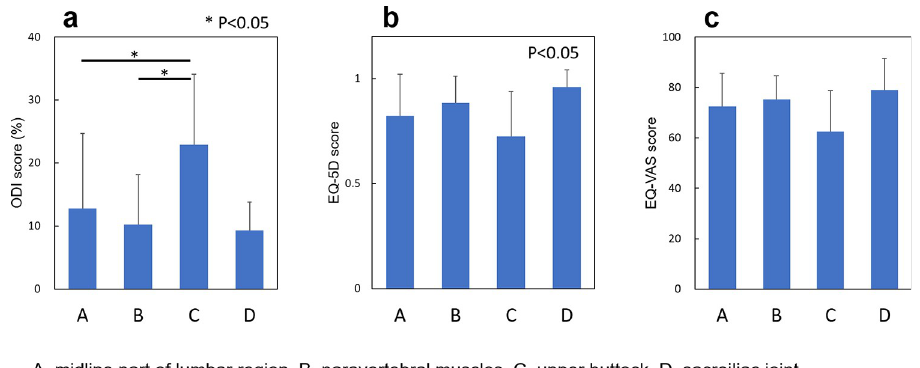
Fig 5. Relationship between the location of low back pain and the extent of QoL issues. a: ODI scores of the LBP- one location group; b: EQ-5D scores of the LBP-one location group; c: EQ-VAS score of LBP-one location group; A. midline of the lumbar region, B. paravertebral muscles, C. upper buttock, D. sacroiliac joint. LBP: Low back pain; QoL: Quality of life; ODI: Oswestry Disability Index; EQ-5D: EuroQol-5 dimension, EQ-VAS: EuroQol-visual analogue